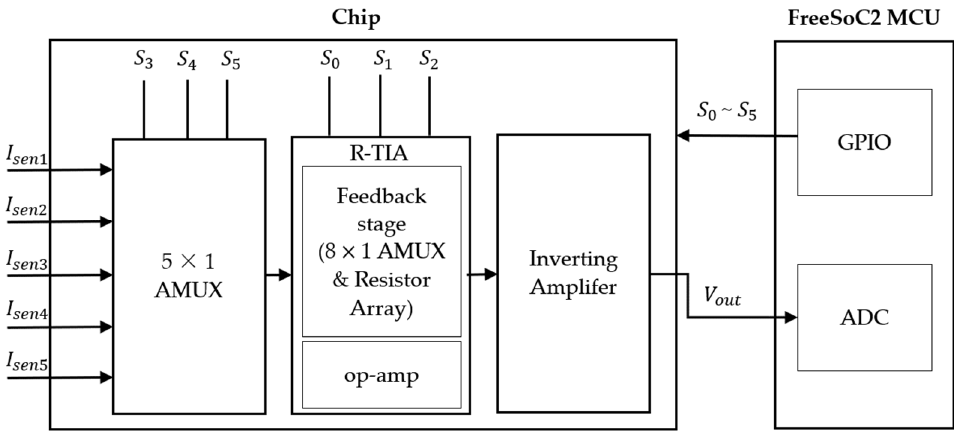
Figure 2. Block diagram of the proposed readout.